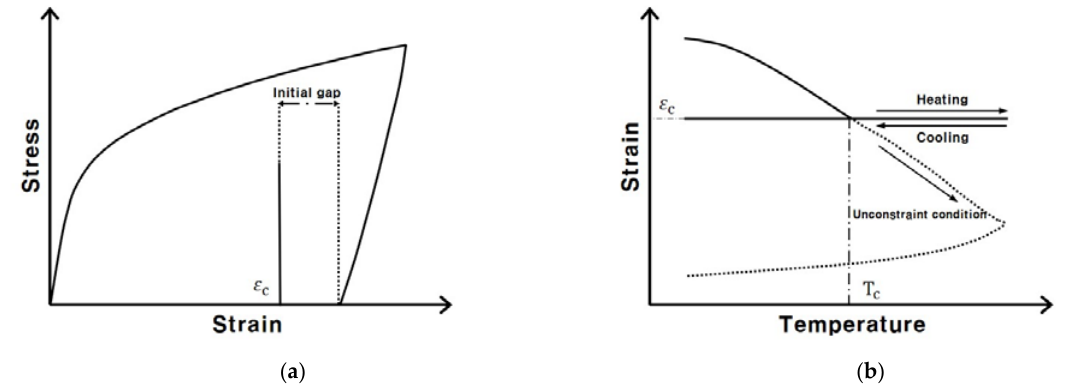
Figure 3. Schematics of pipe joining process by SMA.